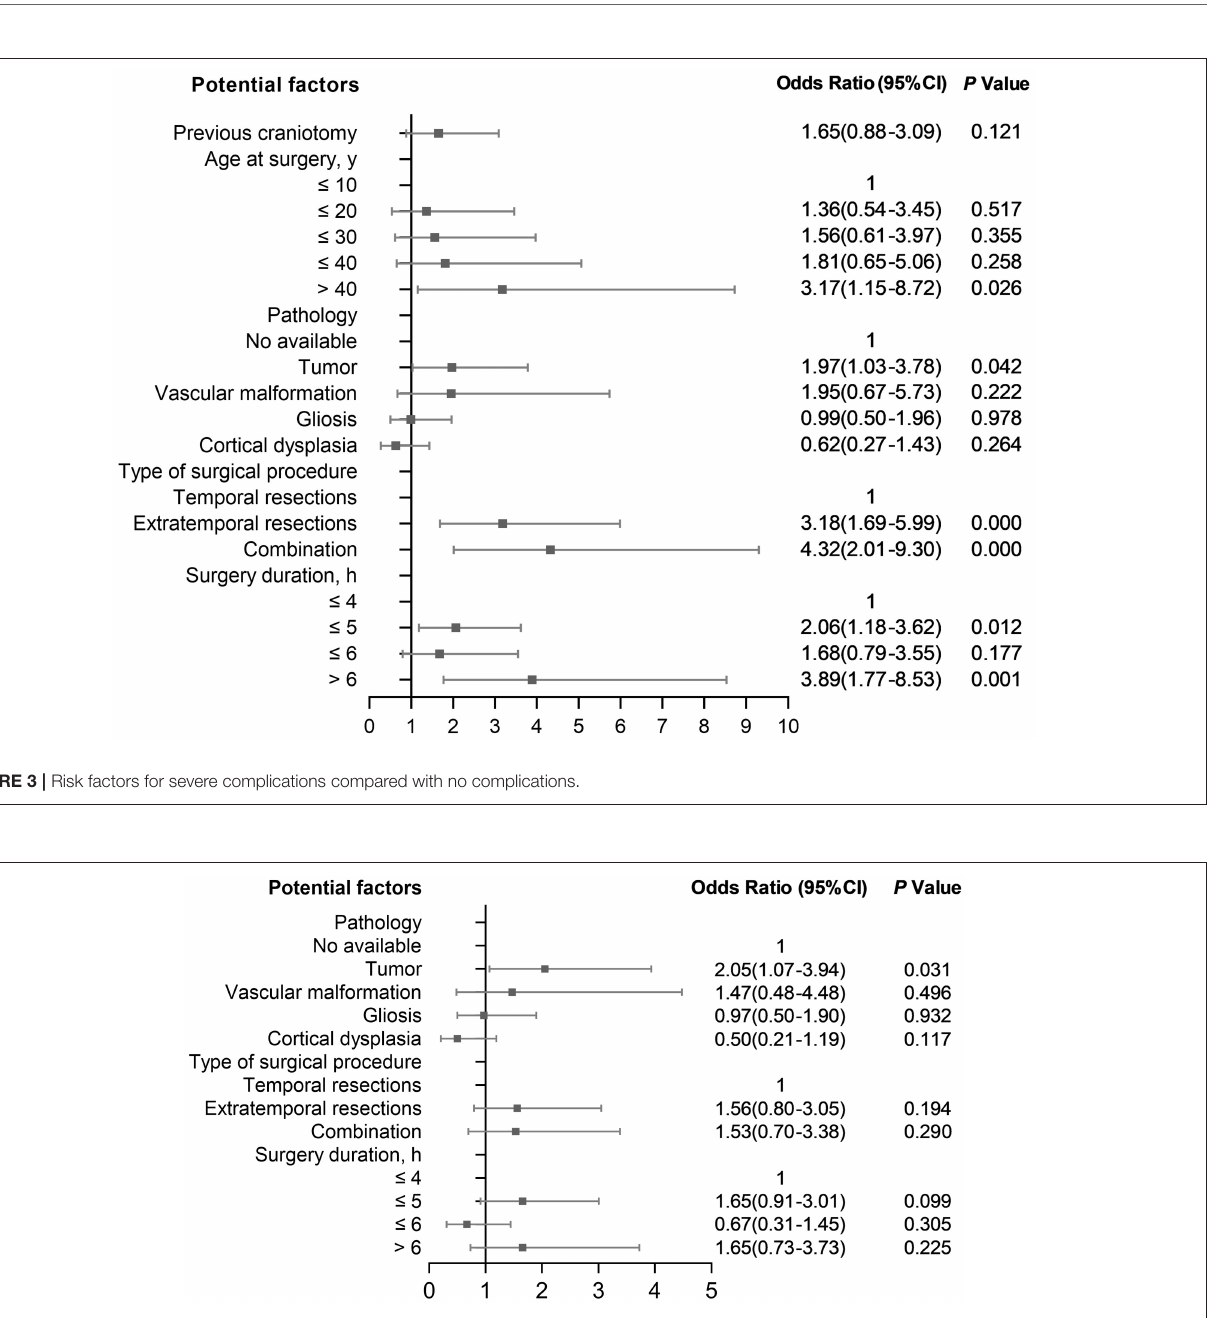
FIGURE 4 | Risk factors for severe complications compared with non-severe